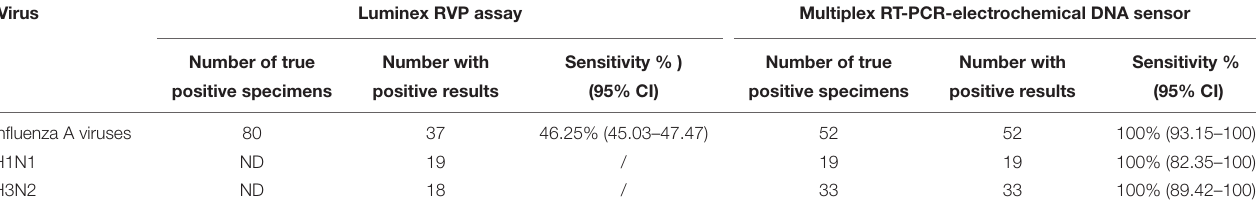
TABLE 2 | Comparison of the detection sensitivity for the clinical H1N1- and H3N2-positive specimens between the Luminex RVP assay and the multiplex RT-PCR-electrochemical DNA sensor. Virus Luminex RVP